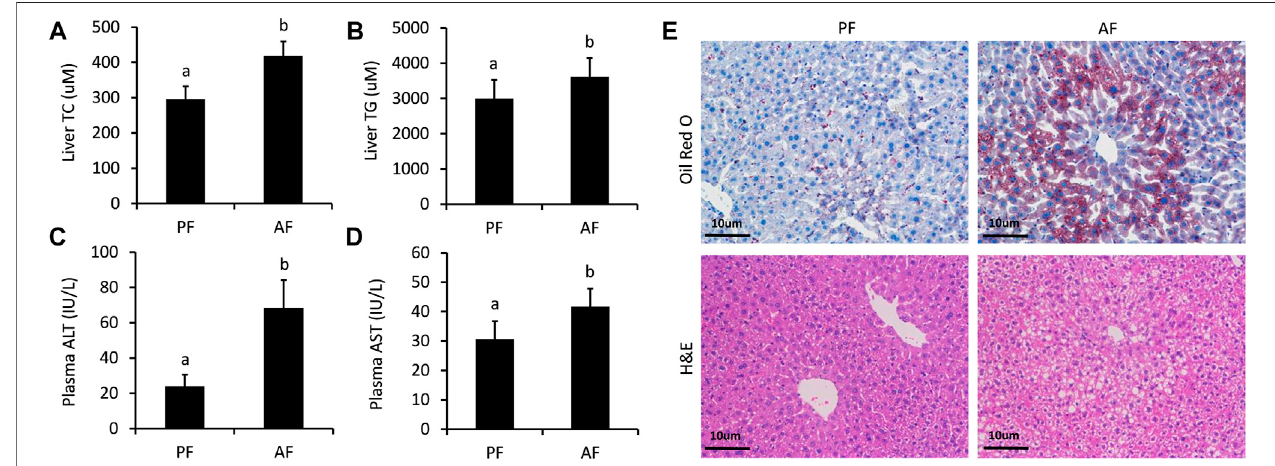
FIGURE 1 | Serum biochemical indices and liver morphologies of ALD mice. (A) Hepatic cholesterol (TC) contents. (B) Hepatic triglyceride (TG) contents. (C) Plasma alanine aminotransferase (ALT) levels. (D) Serum aspartate aminotransferase (AST) levels (E) Hematoxylin and eosin staining and Oil Red O staining of liver tissues. Bars represents 10 µm. Data are expressed as the mean ± SD ( n (cid:2) 6 mice per group).